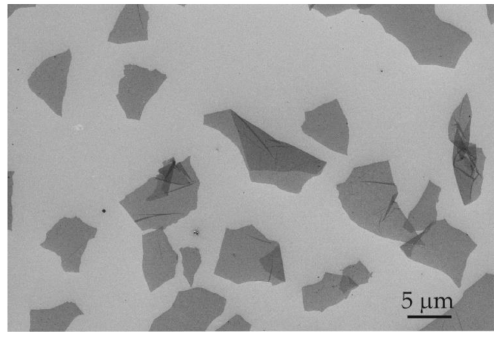
Figure 2. SEM images of GO